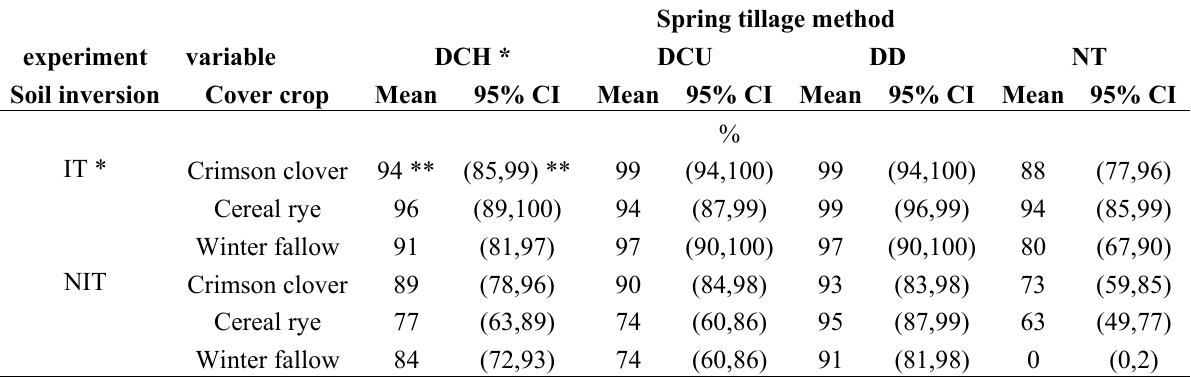
Table 4. Soil inversion by cover crop by spring tillage method interaction means for Palmer amaranth control at 3 WAA *; data combined over production